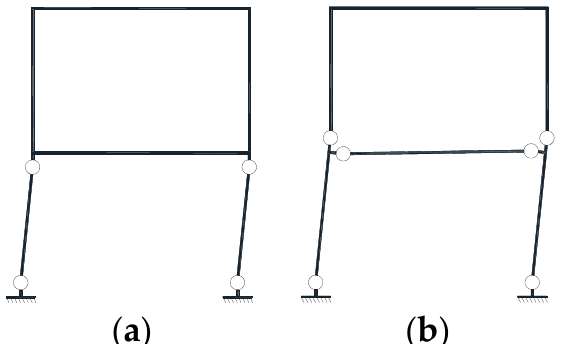
Figure 3. Structural instability caused by plastic hinges: ( a ) plastic hinges formed at both ends of all the columns on the same floor; ( b ) plastic hinges formed at different floors on columns and the ends of all the restraining beams.